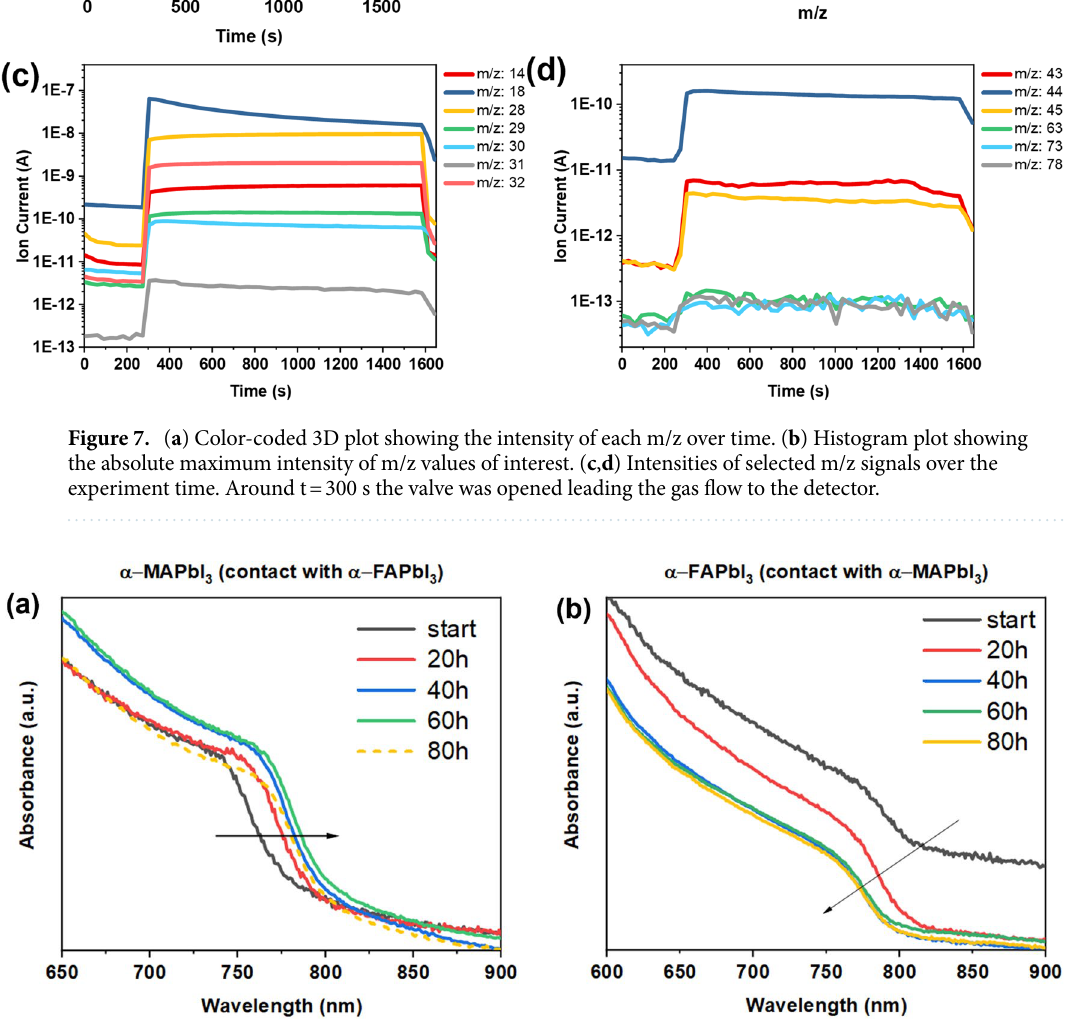
Figure 8. UV–vis spectra of ( a ) α-MAPbI 3 and ( b ) α-FAPbI 3 over 80 h physical contact annealing at 100 °C. The black line in ( b ) shows an offset due to an instrumental